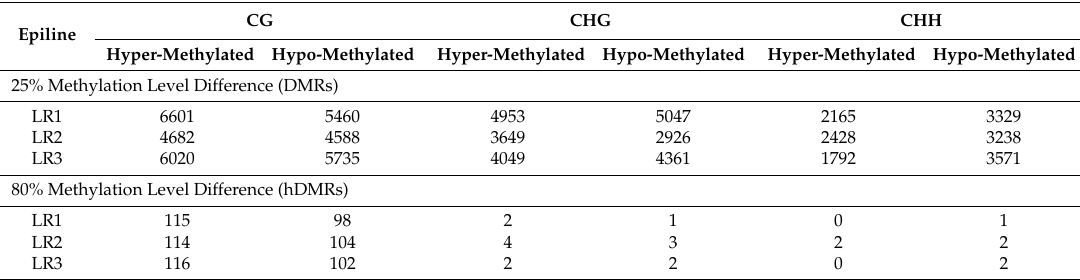
Table 3. Number of differentially methylated regions (DMRs) in rice